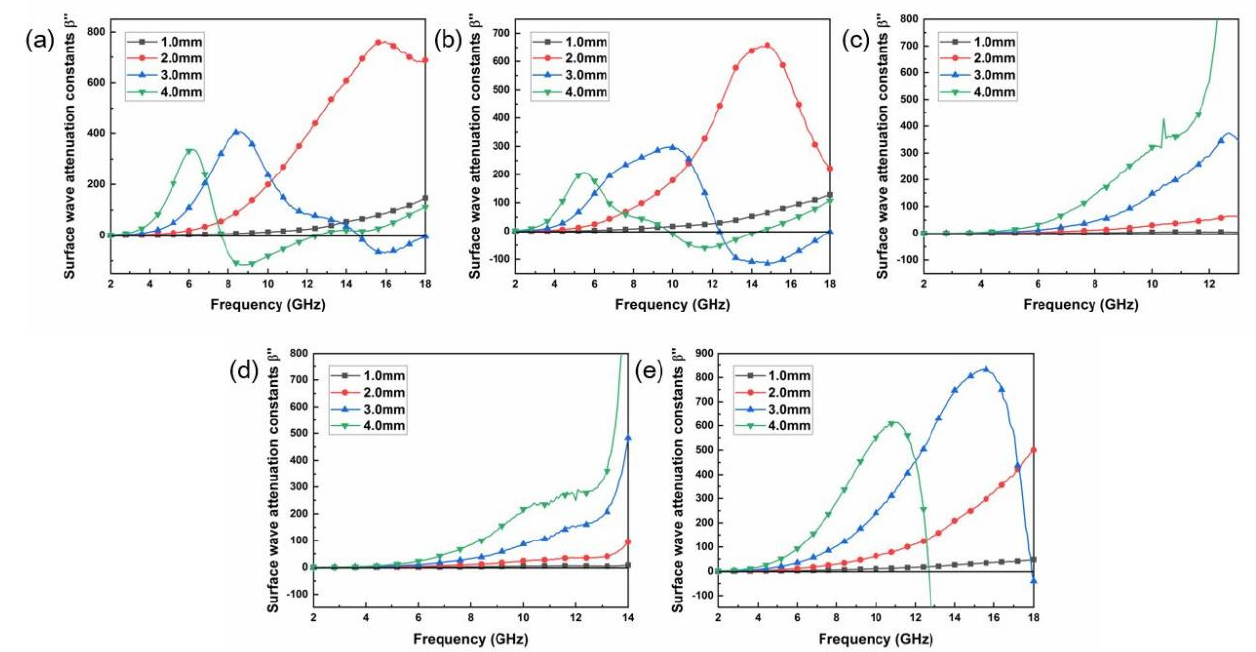
Figure 5. The non-specular scattering suppression of SiC fibers (surface wave attenuation constants β ”): ( a ) S900, ( b ) S1000, ( c ) S1100, ( d ) S1200, ( e ) S0.